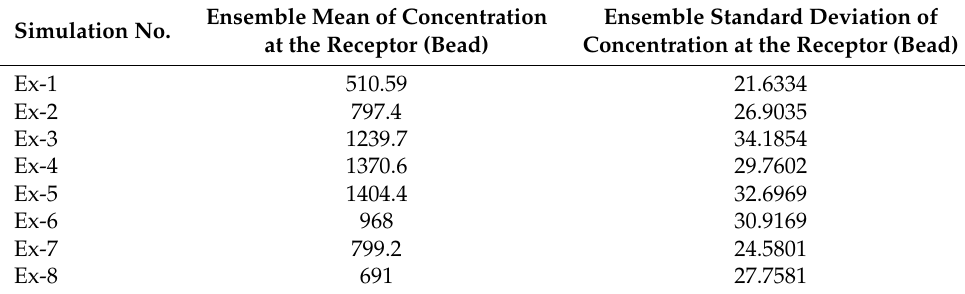
Table 5. The ensemble mean and ensemble and ensemble standard deviation of concentration at the receptor grid (explicit method).